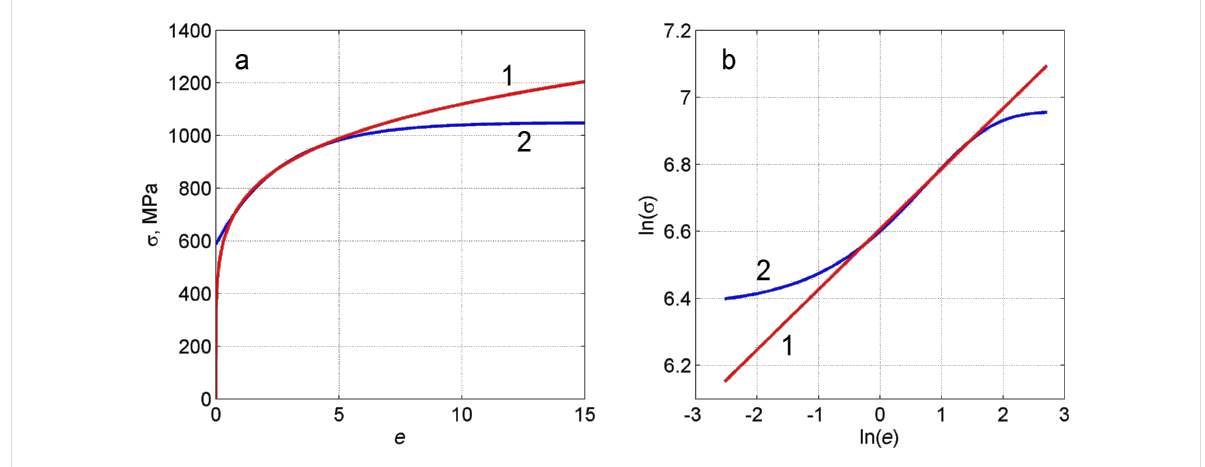
Figure 2: Strain hardening curves used in the numerical simulations. (a): Curve 2 is the experimentally measured stress–strain curve [24] and curve 1 is a fit by the power function σ [MPa] = 740 e 0.18 . (b): log–log Plot of (a) showing that curve 1 is a good approximation of curve 2 in some interval.